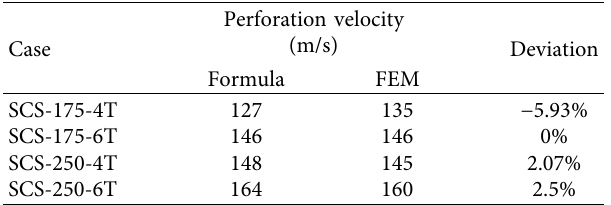
Figure 5: Velocity time-history curves of the projectile with different impact velocities for SCS-175-4T. Table 3: Perforation velocity comparison of SCS wall without tie Table 5: Perforation velocity comparison of SCS-175-6T with a bars for blunt projectile. different distance of tie bar for blunt